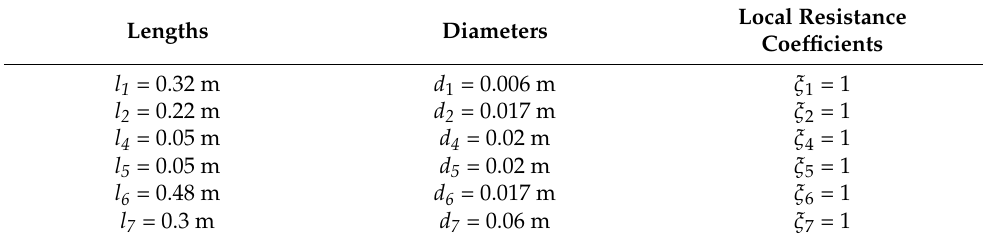
Table 3. Lengths and diameters of connecting gas pipes, and local resistances.